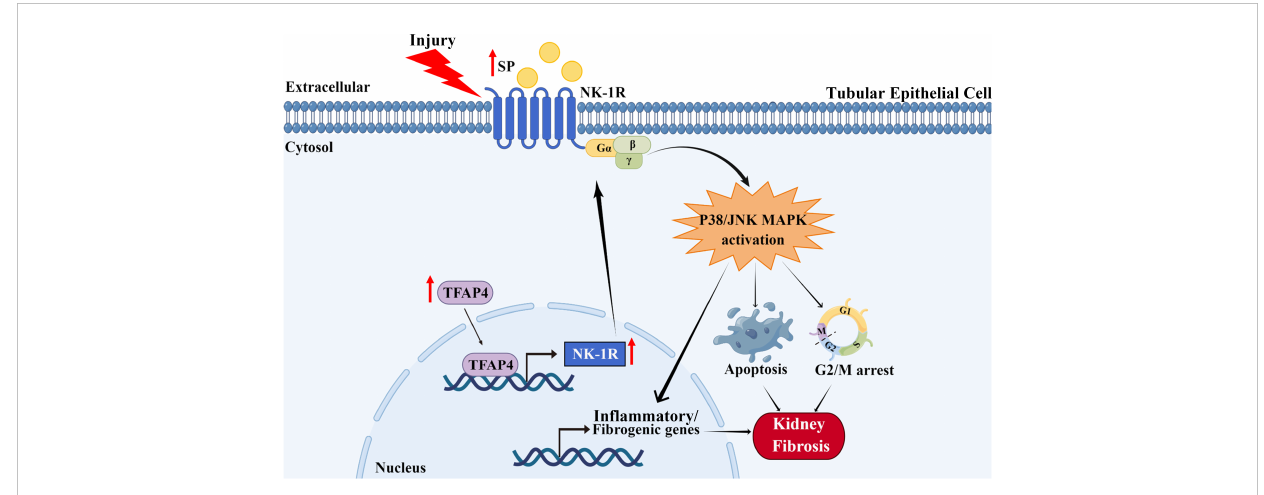
FIGURE 8 Schematic diagram generated by Figdraw for the proposed mechanism by which the SP/NK-1R axis contributes to the pathogenesis of renal fi brosis via modulating in fl ammatory responses and cell fate of tubular epithelial cells through JNK/p38 signaling pathway in